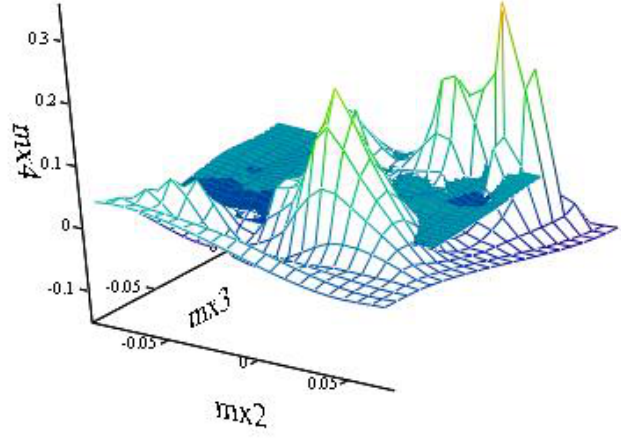
and the total traffic (purple plane) over three iterations (second, third, fourth iteration).